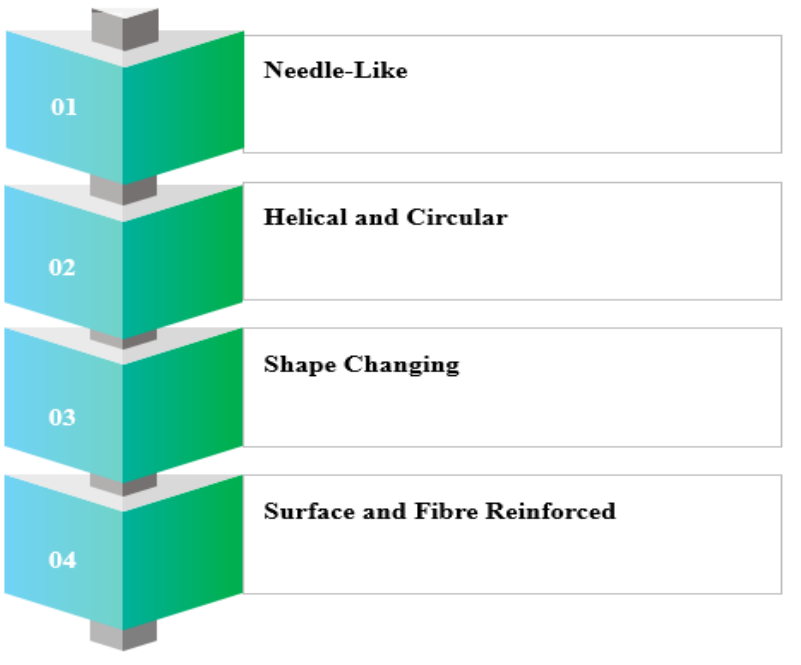
Figure 13. Performance Trade-offs in Bio-inspired structures [50].